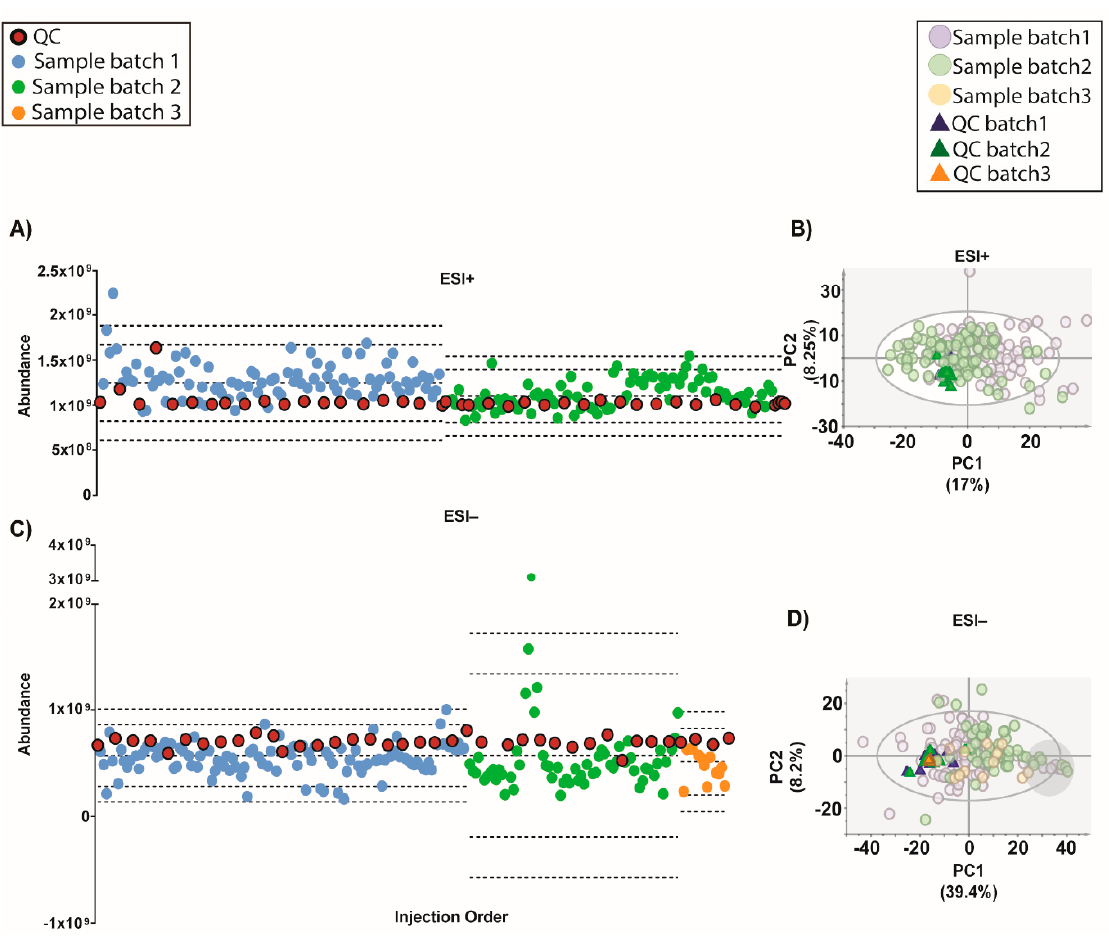
Figure 5. Outcome of the data normalization strategy after QC-SVRC algorithm and QC-norm for both: ESI+ and ESI − modes. ( A,C ) Quality control chart of ESI+ and ESI − modes, respectively. Samples with a TUS higher than 3 SD of the mean or lower than -3 SD were removed from the PCA model. ( B,D ) PCA plots of ESI+ and ESI − mode, respectively. Signals with %RSD < 30% on QCs were kept, and UV scaling was used. Features in ESI+ and ESI − modes respectively: 880 and 525. Legend. TUS plot : Blue and green dots: samples of batch1 and batch2, respectively, red dots: QCs. Dotted lines represent the mean +/ − 2 and 3 SD for each batch independently. PCA : Blue dots and dark blue triangles are samples and QCs measured in batch1, respectively; green dots and dark green triangles are samples and QCs from batch2, respectively. Grey circle signals samples with low levels of IS mix.